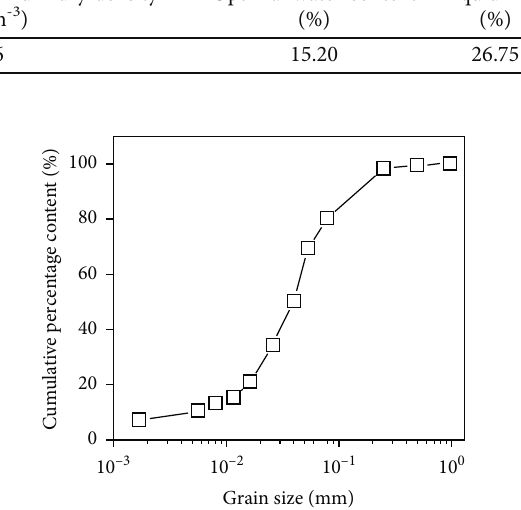
Figure 1: The particle gradation curve of the Qinghai silty clay.